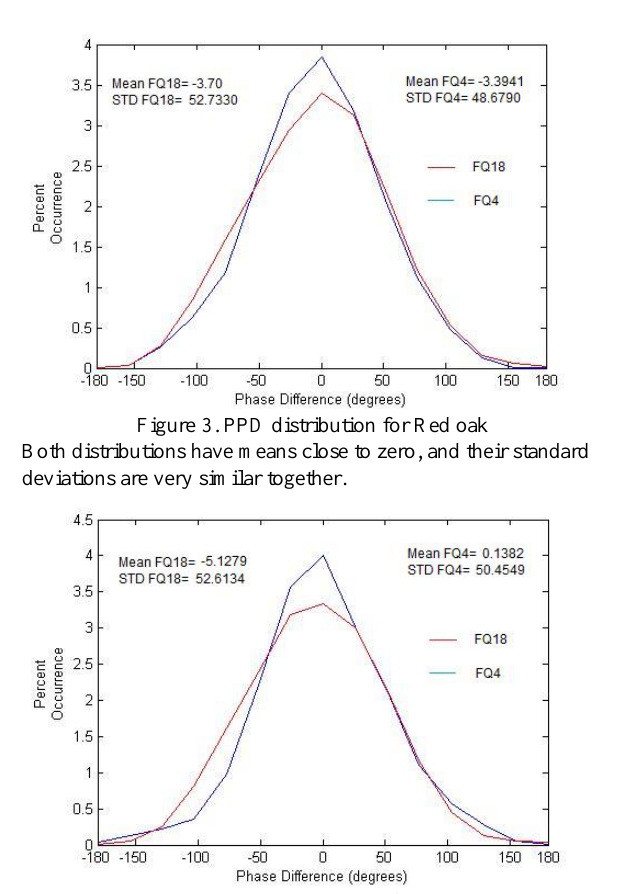
Figure 4. PPD distribution for Poplar